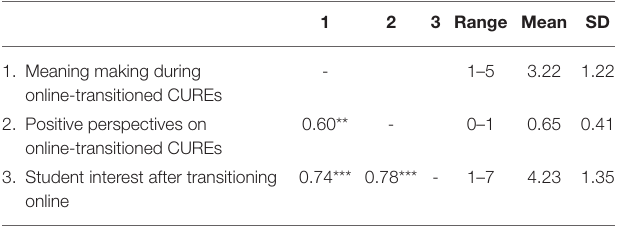
TABLE 2 | Descriptive statistics and partial correlations among the variables of interest ( n = 27).